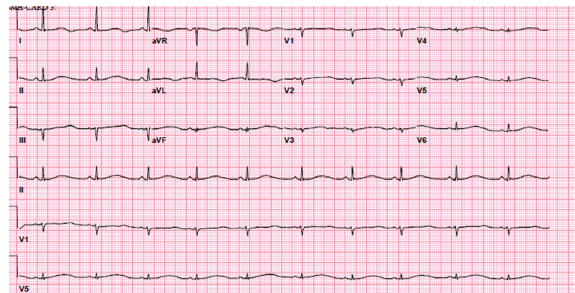
Figure 1: 12-lead ECG showing markedly prolonged QT interval.